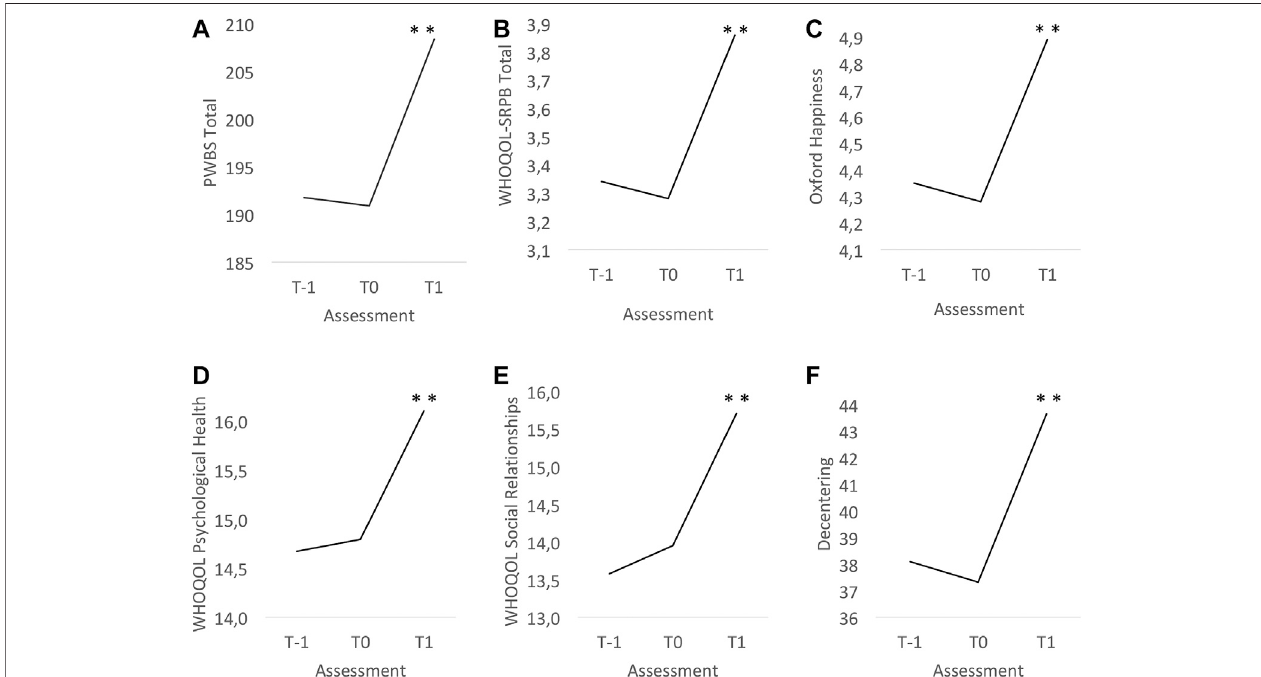
FIGURE 2 | Graphs of the mean values (dots) of primary and secondary outcomes at T-1, preassessment (T0) and postassessment (T1). (A) Psychological Well- BeingScales: Total Scale. (B) WHO Quality ofLife Spirituality, Religiousness, and Personal Beliefs (WHOQOL-SRPB): Total Scale. (C) Oxford Happiness Questionnaire. (D) World Health Organization Quality of Life-BREF (WHOQOL-BREF): Psychological Health Scale. (E) World Health Organization Quality of Life-BREF (WHOQOL- BREF): Social Relationship Scale. (F) EQ-Decentering Scale. * p value < 0.05. ** p value < 0.01. T-1 (cid:1) Two months before entering the center; T0 (cid:1) 15 days before entering the center; T1 (cid:1) 15 days after entering the center. PWBS, Psychological Well-Being Scales; WHOQOL-SRPB, World Health Organization Quality of Life Spirituality, Religiousness and Personal Beliefs; WHOQOL-BREF, World Health Organization Quality of Life.